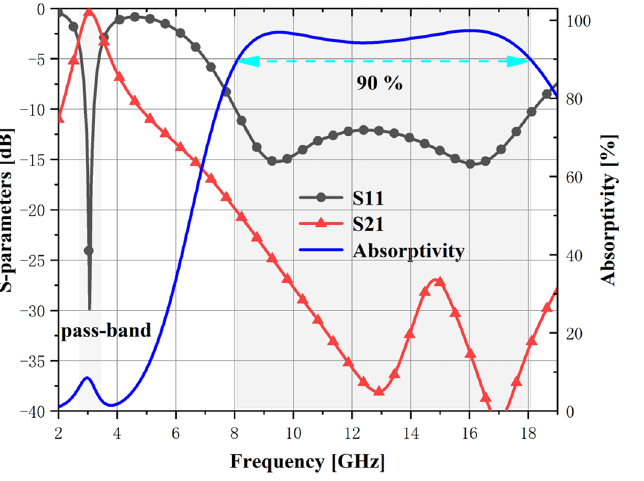
Fig. 4. S-parameter results and absorptivity of the designed FSR.